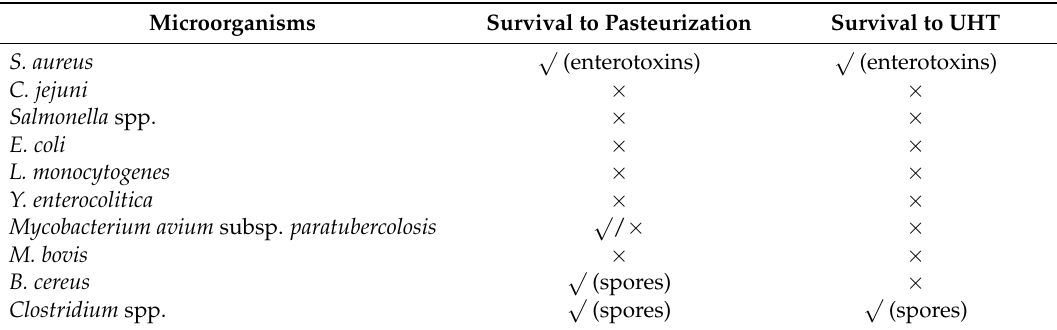
Table 5. Survival of microorganisms to heat